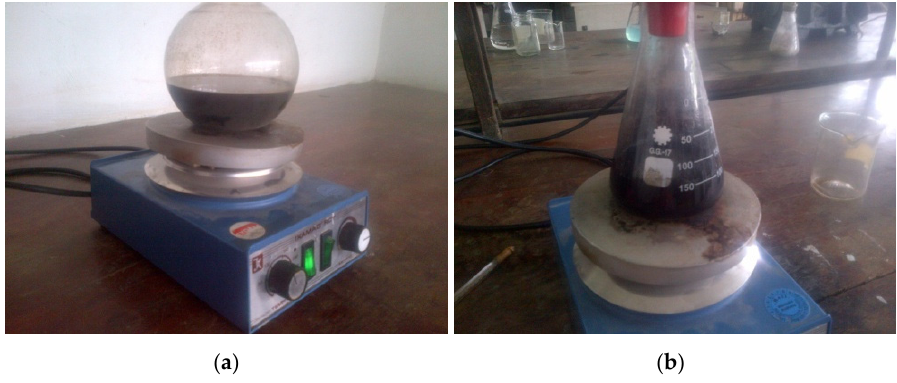
Figure 1. ( a ) Solvent extraction and ( b ) Adsorption process with activated charcoal.